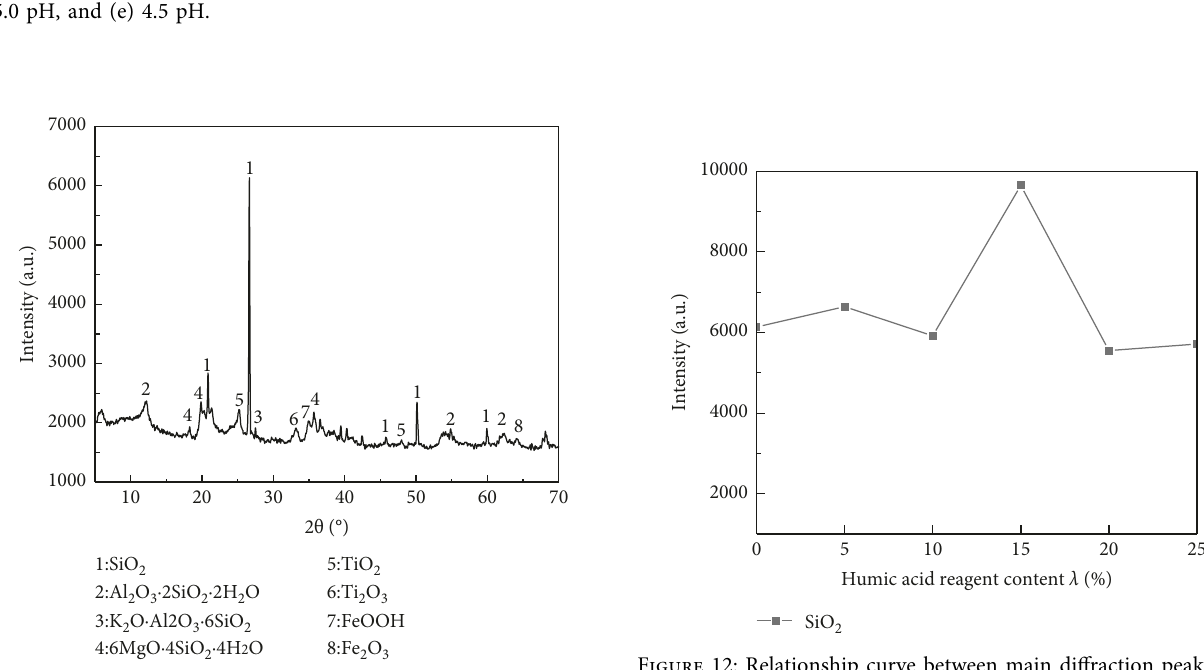
Figure 11: XRD pattern of cohesive soil.